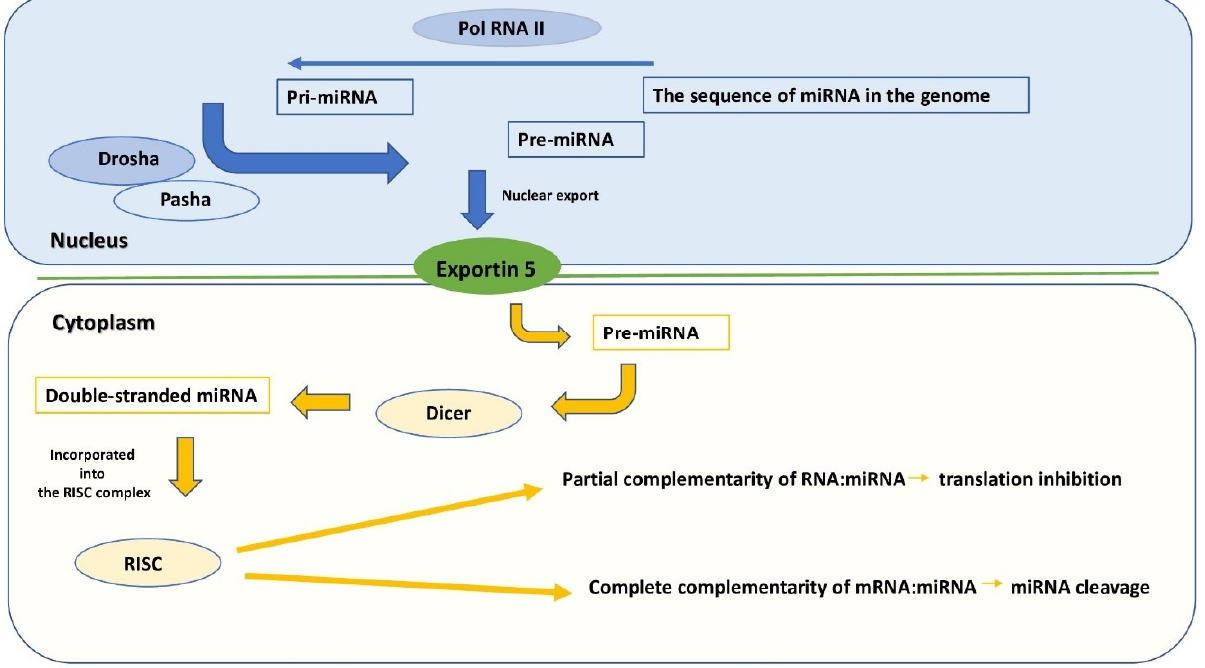
Figure 1. miRNA biogenesis pathway. miRNA genes are transcribed from the sequences encoding them in the genome most often by RNA polymerase II and the resulting pri-miRNA transcripts are subject to modifications of the 5 ′ (cap) and 3 ′ (polyadenyl tail) end. They are treated by the Drosha and Pash proteins by cutting out a region with the structure of a hairpin, thanks to which pre-miRNA molecules with a length of about 70 nucleotides are formed. pre-miRNAs are exported from the nucleus by the nuclear transporter exportin 5. In the cytoplasm, pre-miRNA is cut by the Dicer enzyme into double-stranded molecules about 22 nucleotides long. The less thermodynamically stable of the strands is incorporated into the RISC (RNA-induced silencing complex). A high degree of complementarity of the transcript to the RISC-bound miRNA strand results in degradation of the transcript, while partial complementarity inhibits translation.